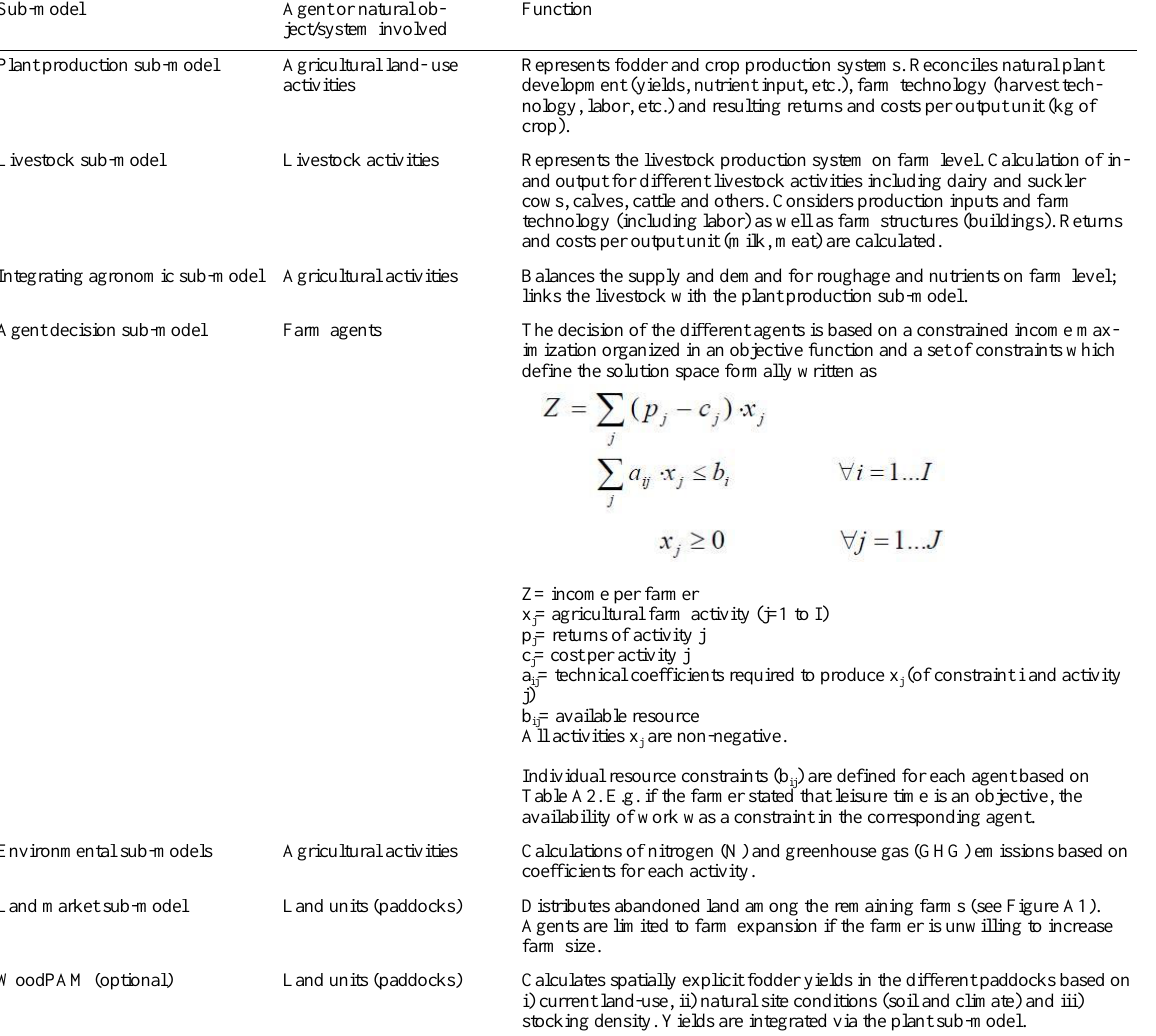
Table A1 : Short description of the ALUAM-AB sub-models